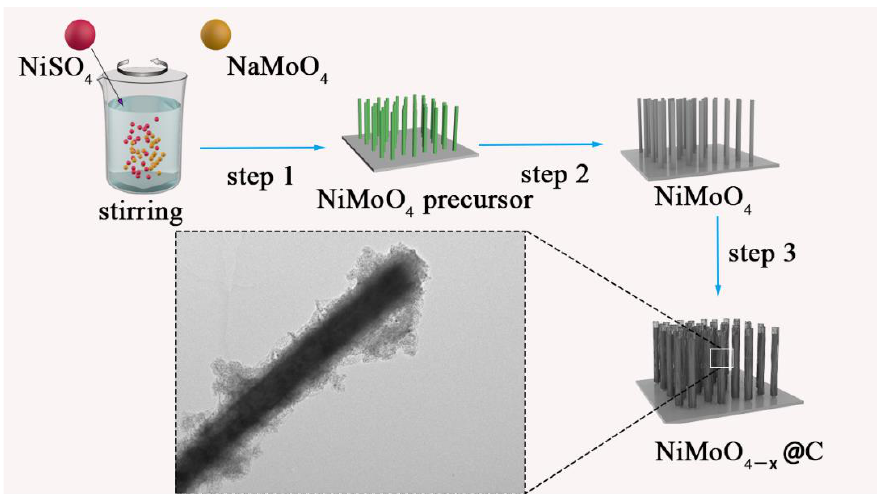
Figure 1. Schematic illustration of the synthesis process of oxygen-deficient NiMoO 4 @carbon nanowire arrays (NWAs) (denoted as “NiMoO 4 − x @C”). Step 1, growth of the NiMoO 4 NWAs precursor directly on a ferronickel foam substrate using a hydrothermal process; Step 2, conversion of the NiMoO 4 NWAs precursor into the NiMoO 4 NWAs via annealing in Ar; Step 3, fabrication of NiMoO 4− x @C composite by sucrose coating followed by annealing in Ar.